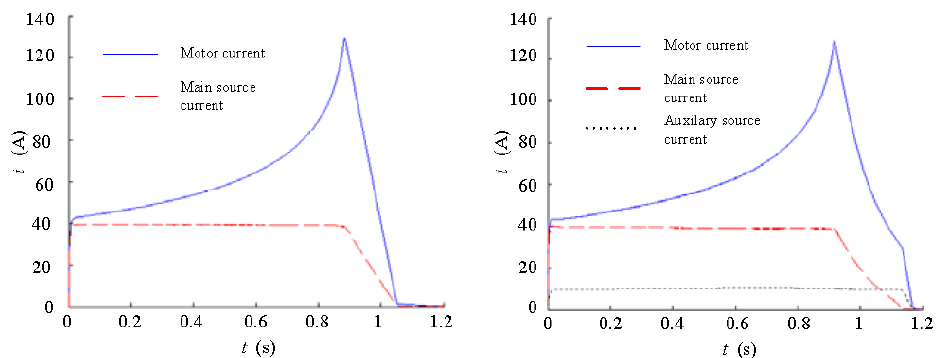
Figure 8. ( a) The charging current for the main source only; (b) The charging currents for both the main and auxiliary